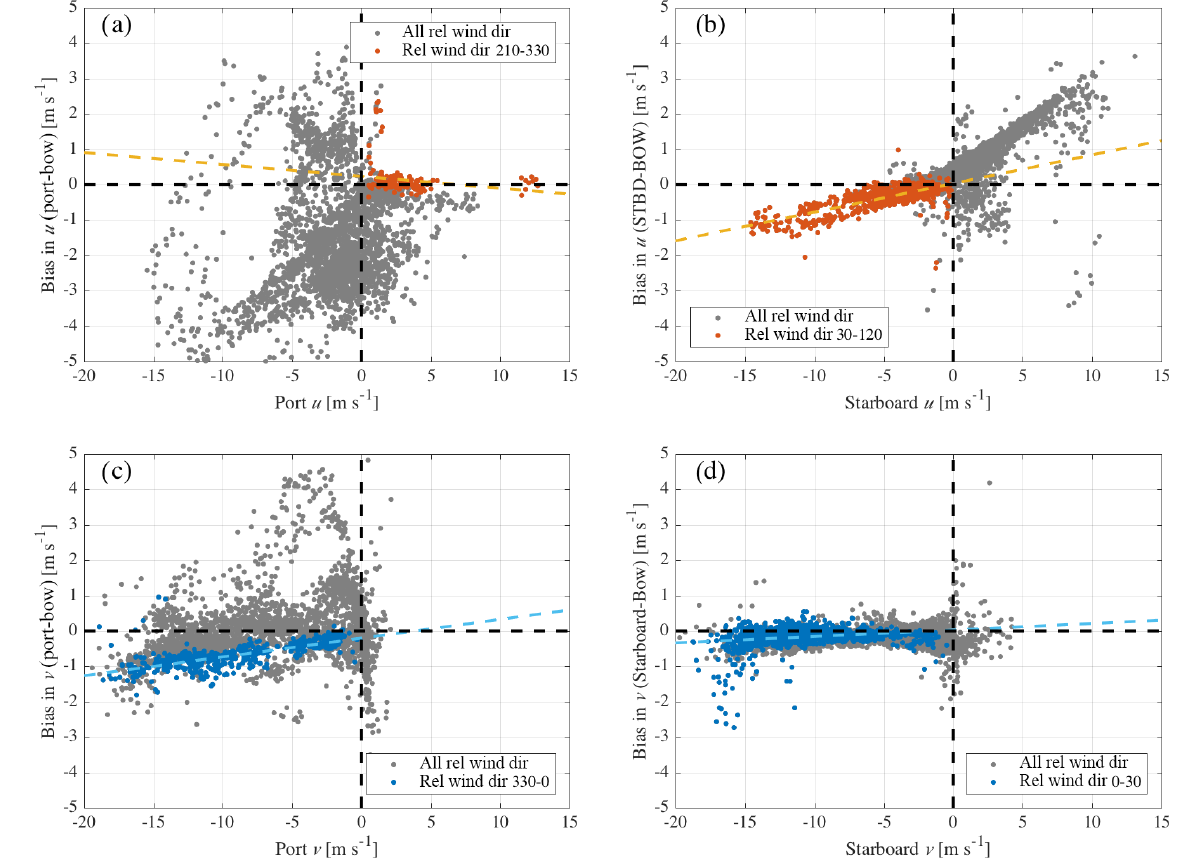
Figure 17. Comparisons between winds measured by the bridge sonic anemometers (“Port” and “Starboard”) and the bow-mast anemometer (“Bow”) on NOAA Ship Ronald H. Brown during CalWater-2, 2015. (a) The bias in u (Port − Bow) as a function of observed wind speed at Port, (b) similar to (a) , but for the Starboard sonic; (c) and (d) similar to (a) and (b) for the v wind component. u is defined perpendicular to the ship’s orientation and v is defined